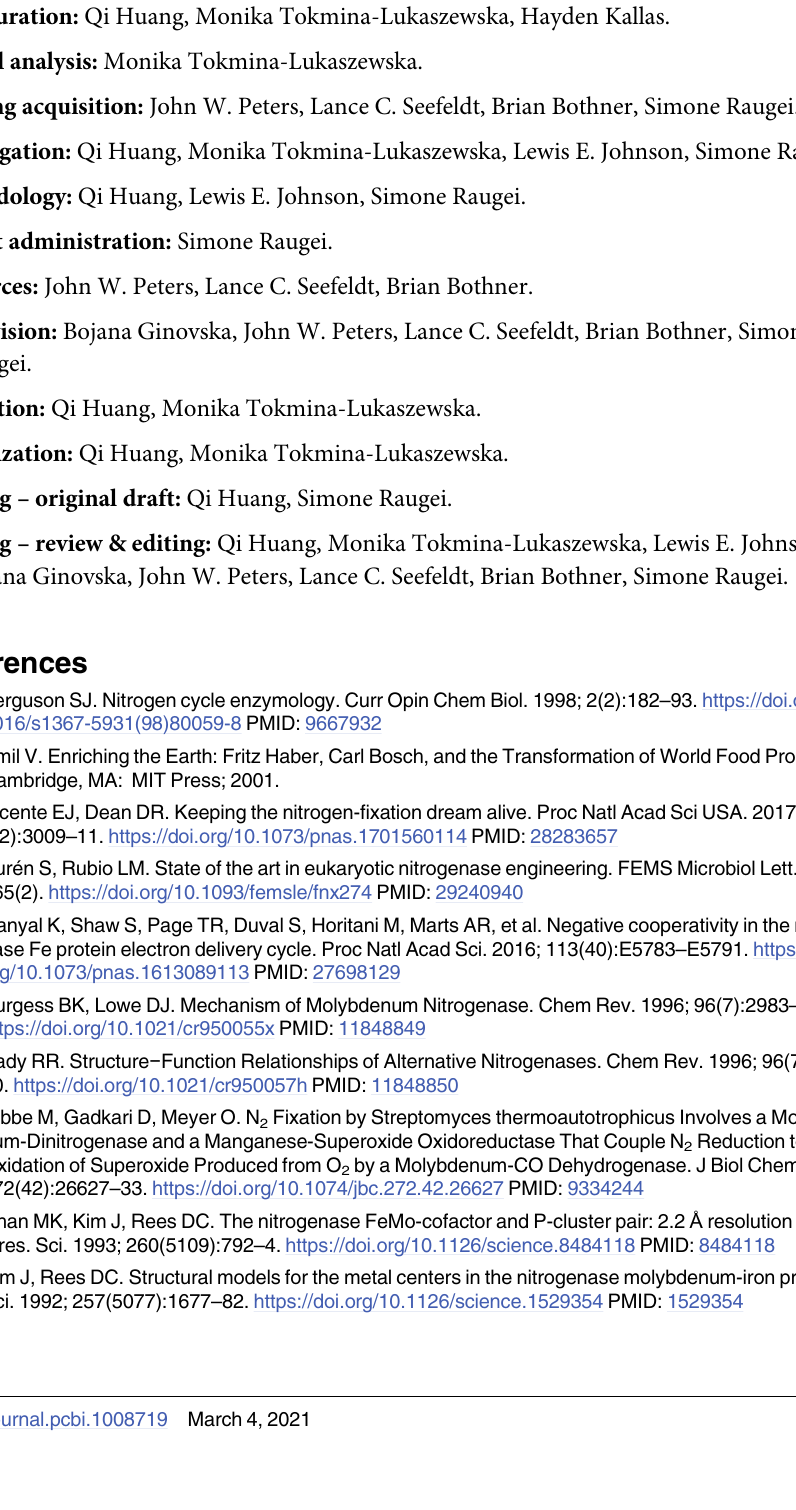
correlation. Diameter of the circle represents significance; larger is more significant correla- tion. Peptides are group based on hierarchical clustering. Green bar indicates peptides which are negatively correlated in free MoFe